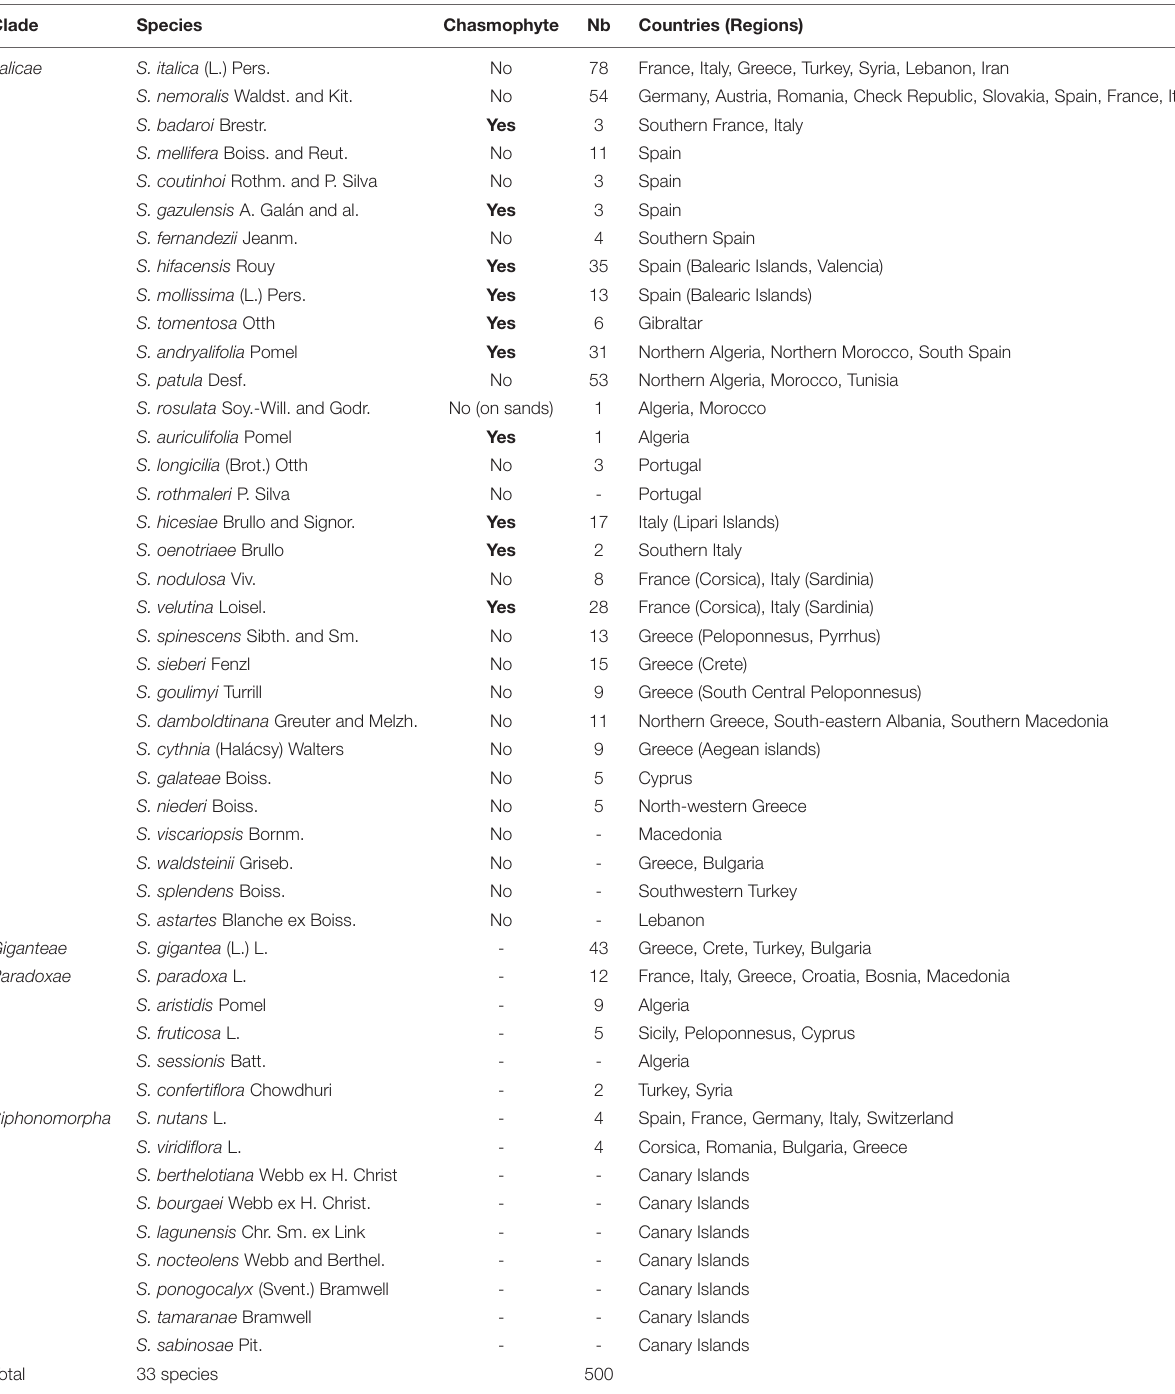
TABLE 1 | List of the sampled species, their chasmophytic status, their distribution area and the number of specimens sequenced for each. Clade Species Chasmophyte Nb Countries (Regions)